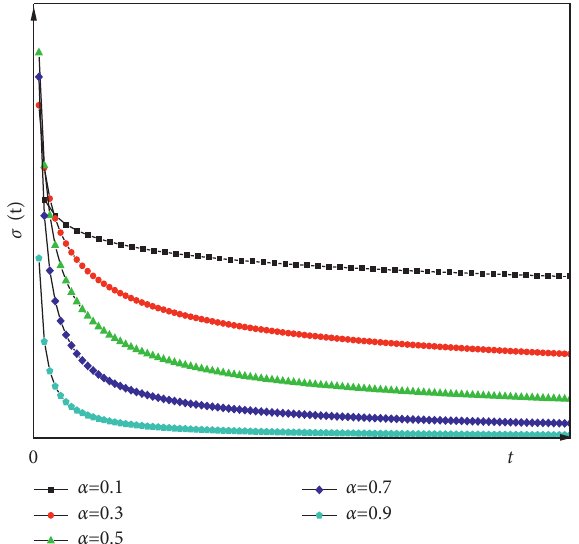
Figure 4: Stress relaxation curves of fractional soft component under different values of